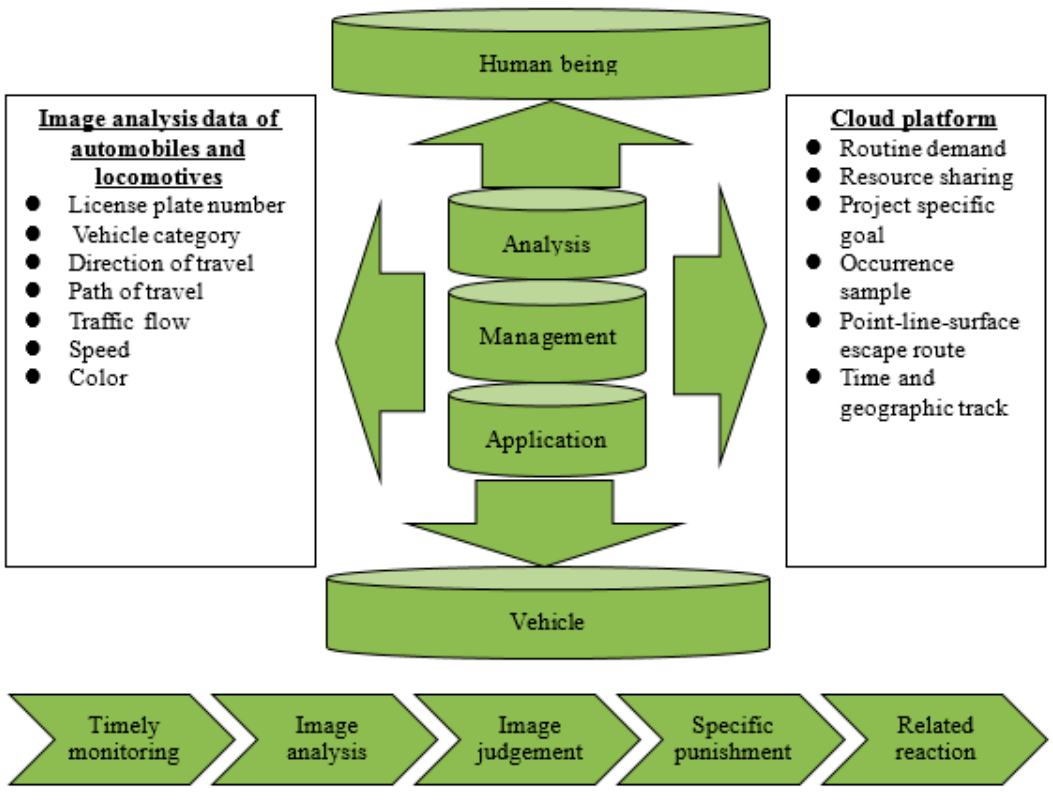
Figure 11. Expected benefits diagram.